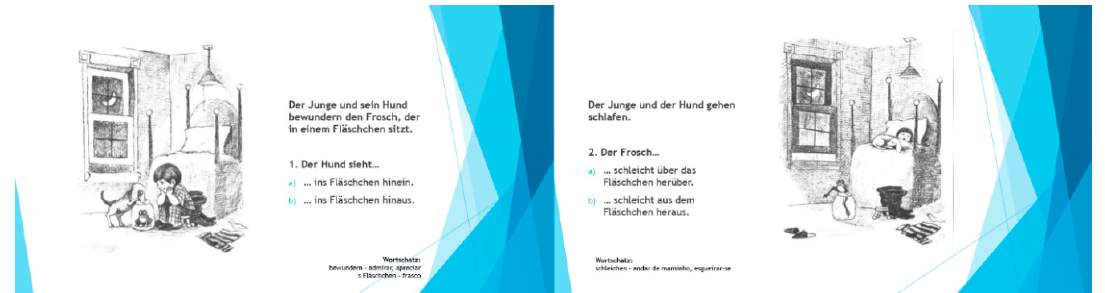
Figure A28. Posttest: Binary-choice recognition task.